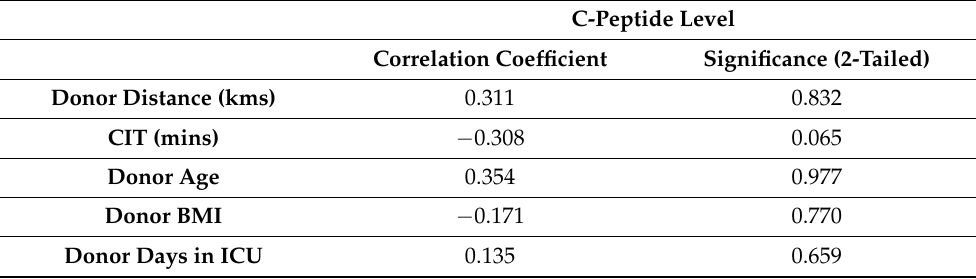
Table 3. Factors affecting C-peptide levels. The correlation coefficient of each factor in relation to C-peptide level as a positive transplant outcome are shown with their significance. Donor distance, CIT, donor BMI, donor days in ICU and recipient distance all showed a weak positive correlation to C-peptide levels (as one increases, C-peptide level